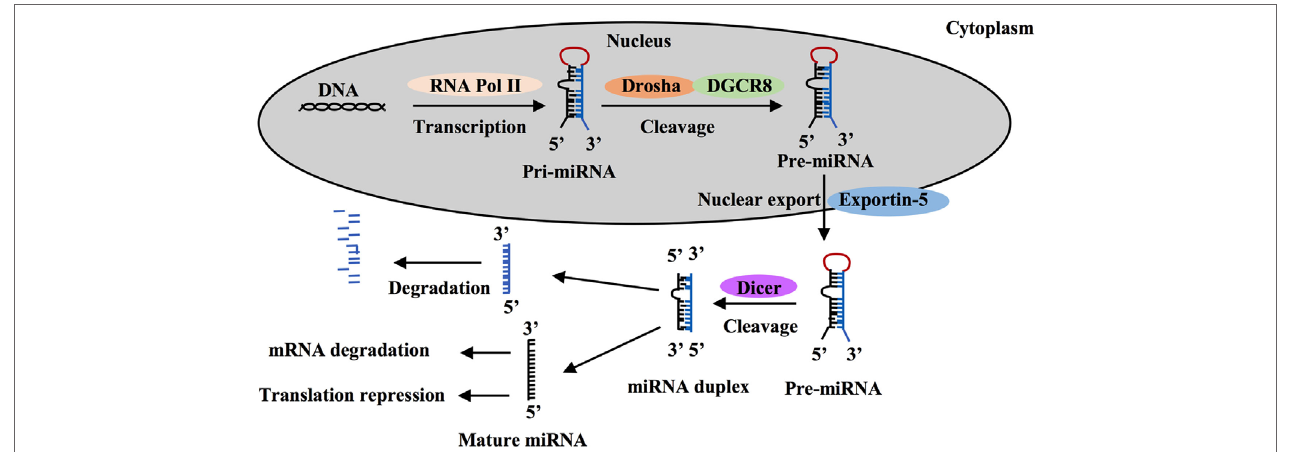
FigURe 1 | MicroRNA (miRNA) processing and function. MiRNA is first transcribed as long hairpin primary RNA (pri-miRNA) by RNA polymerase II and cleaved into hairpin precursor miRNA (pre-miRNA) by the complex Drosha-DGCR8 in nucleus. This pre-miRNA then is exported to the cytoplasm by exportin-5 protein and cleaved to two strands by endoribonuclease Dicer, one strand becomes a mature miRNA and silence target mRNAs through mRNA degradation or translation repression and the other is degraded.